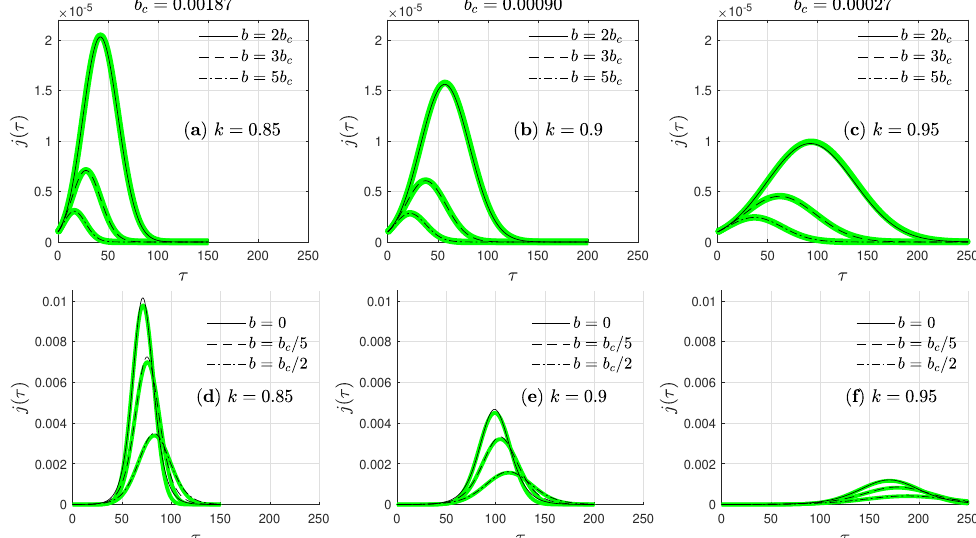
Figure 8. Differential rate, j ( τ ) , of infected population fraction versus reduced time, τ , for three different k ∈ { 0.85,0.90,0.95 } and various reduced vaccination rates, b / b c . Here, η = 10 − 6 is used. The panels ( a – c ) show the regime b > b c , while ( d – f ) show results for b < b c including b = 0 (SIR model). To rate the effect of the parameters, all three plots of each row are shown on identical scales. While the peak time increases with increasing k and decreasing b , the peak height dramatically decreases with increasing b . The critical b c depends on k and η , see Equation (92) and Figure 4. The area under the curves is the total cumulative fraction J ∞ of infected persons. The black lines are the exact numerical results, the green lines are the analytical approximant, given in Section